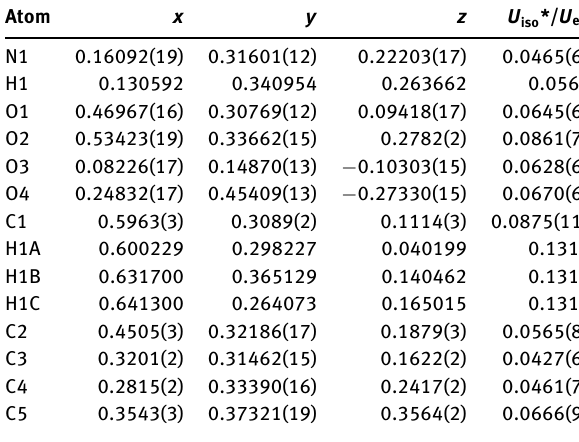
Table 2: Fractional atomic coordinates and isotropic or equivalent isotropic displacement parameters (Å 2